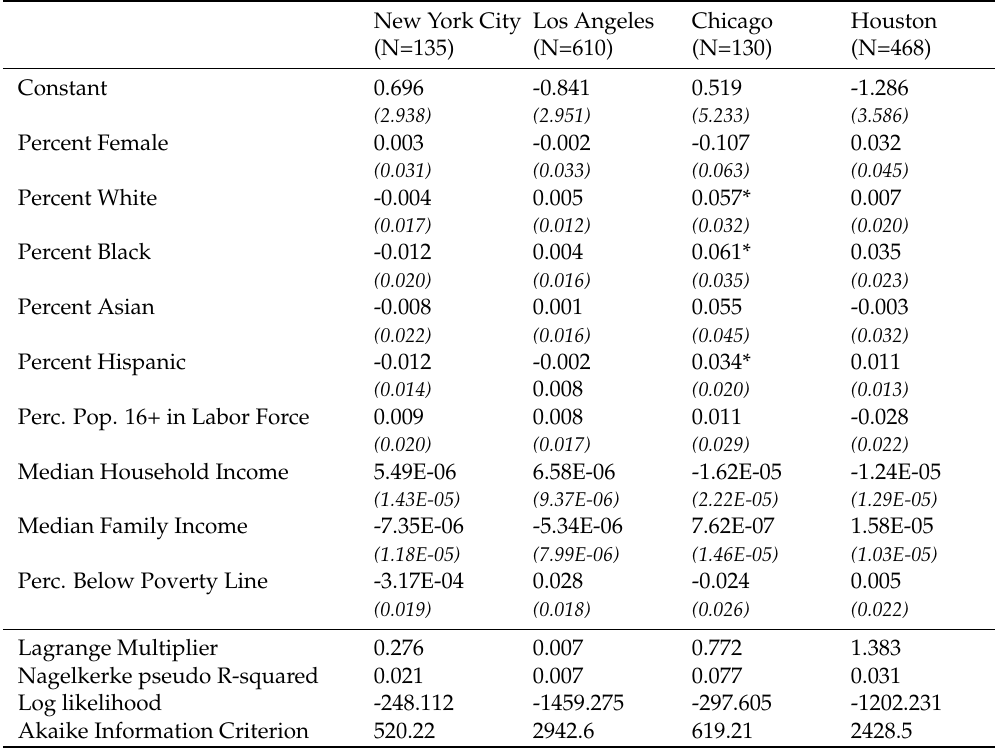
Table 10: Spatial error regression model results for change in visit duration to the Fuel Station place type, split by